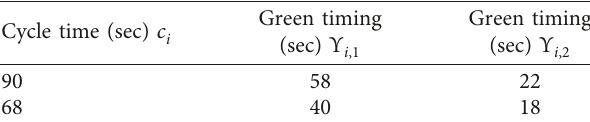
Figure 4: Convergence graph of the Algorithm 1 for Test Network- 1. Table 1: Optimal signal timings for E ∗ in Test Network-1.